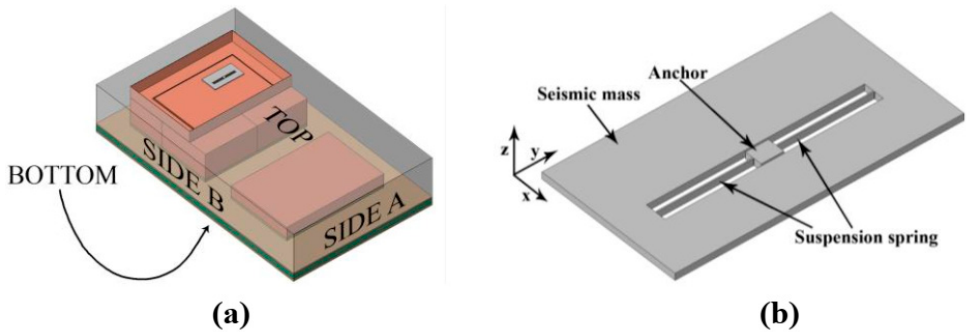
Figure 4. ( a ) macro-scale model of the whole package ( b ) meso-scale model of the uniaxial MEMS accelerometer [42]. accelerometer [42].